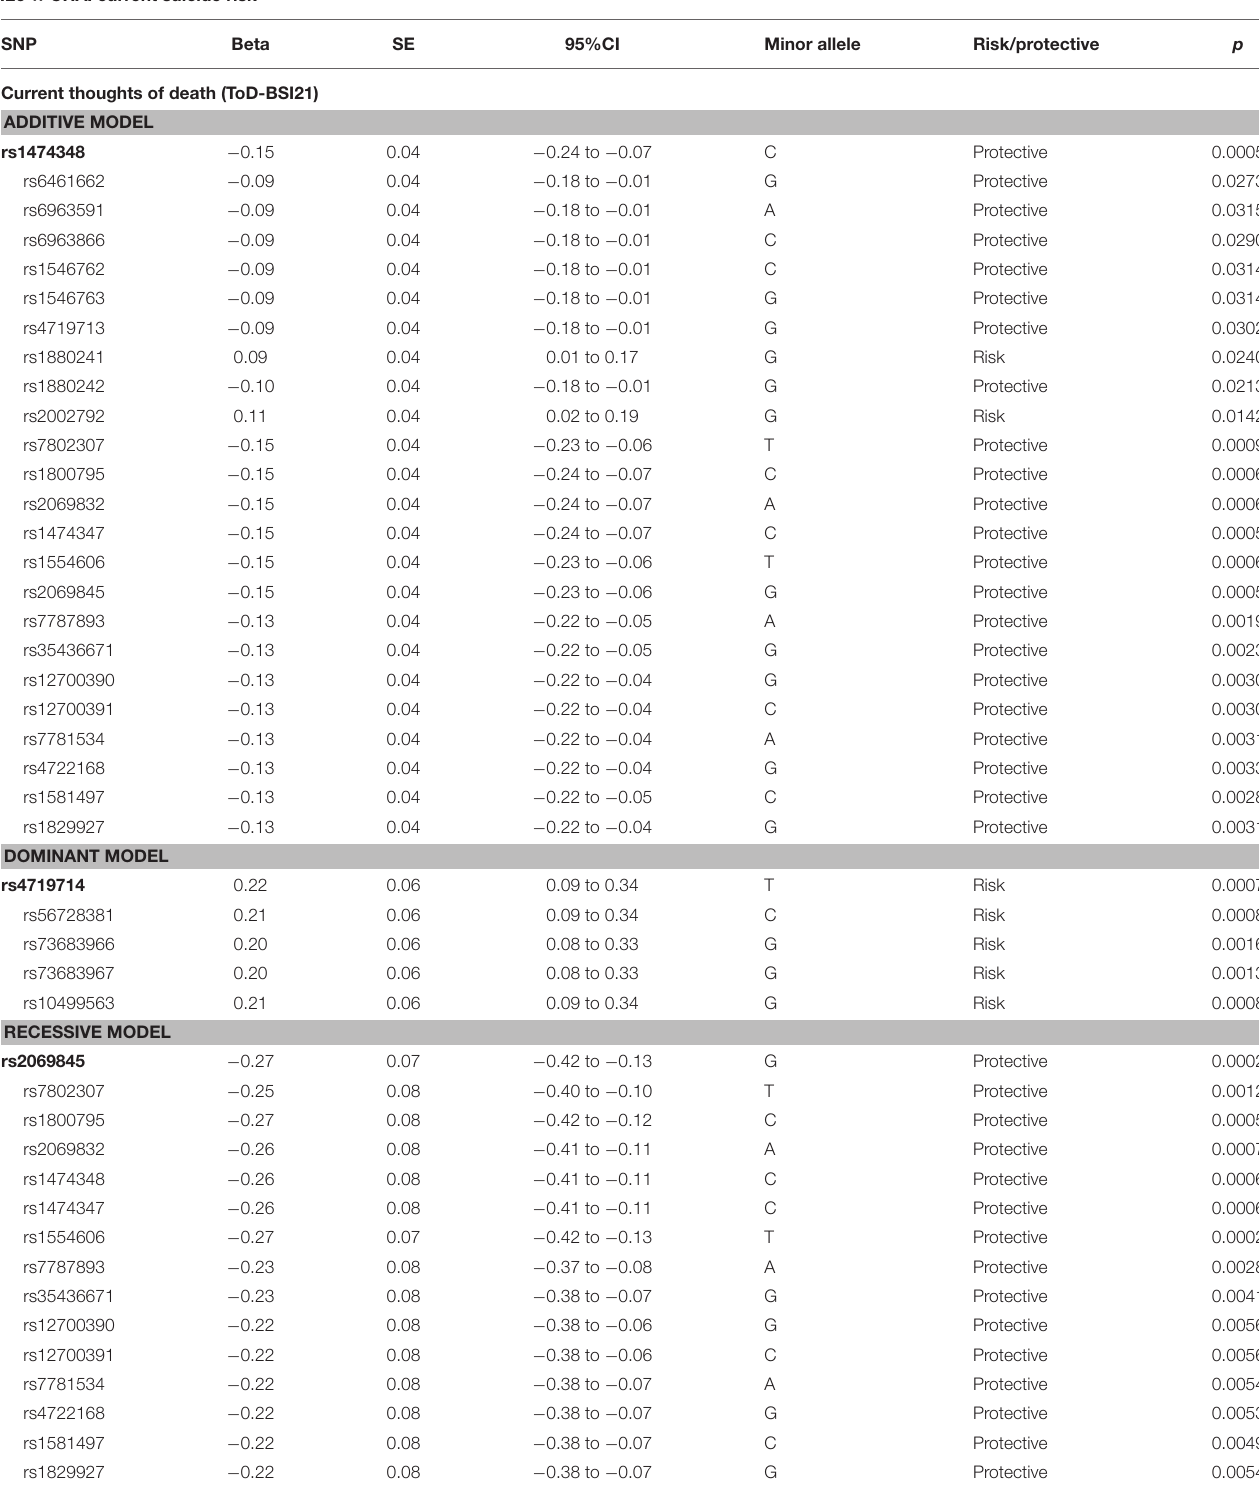
TABLE 4 | Interaction effects between IL6 variation and childhood adversities on current thoughts of death. IL6 × CHA: current suicide